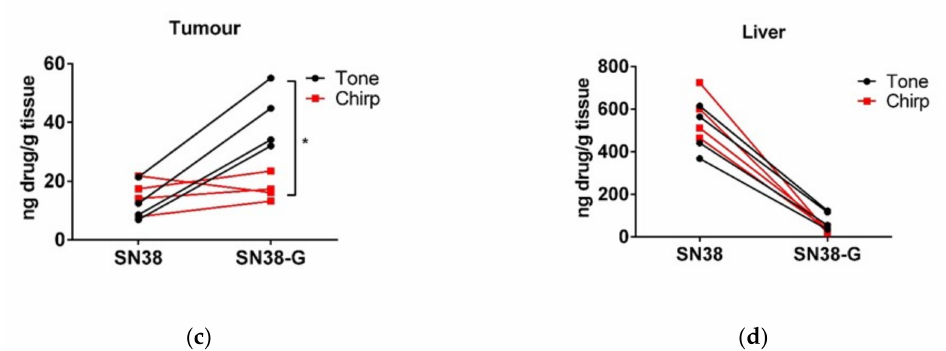
Figure 4. Drug delivery and metabolism using a tone burst trigger versus a chirp trigger. ( a ) Repre- sentative tone and chirp ( b ) US sequences. Concentrations of SN38 and metabolite SN38-G detected in tumours by LC-MS/MS one hour post injection of thMBs, followed by either a tone (black circles) or chirp (red squares) US triggers localised over the tumour ( n = 4 per trigger type). Linked data points show the results from individual mice. Mann–Whitney U test showed a significant difference in the SN38-G measured in the tumour ( c ) but not the non-sonicated liver ( d ) when a tone US